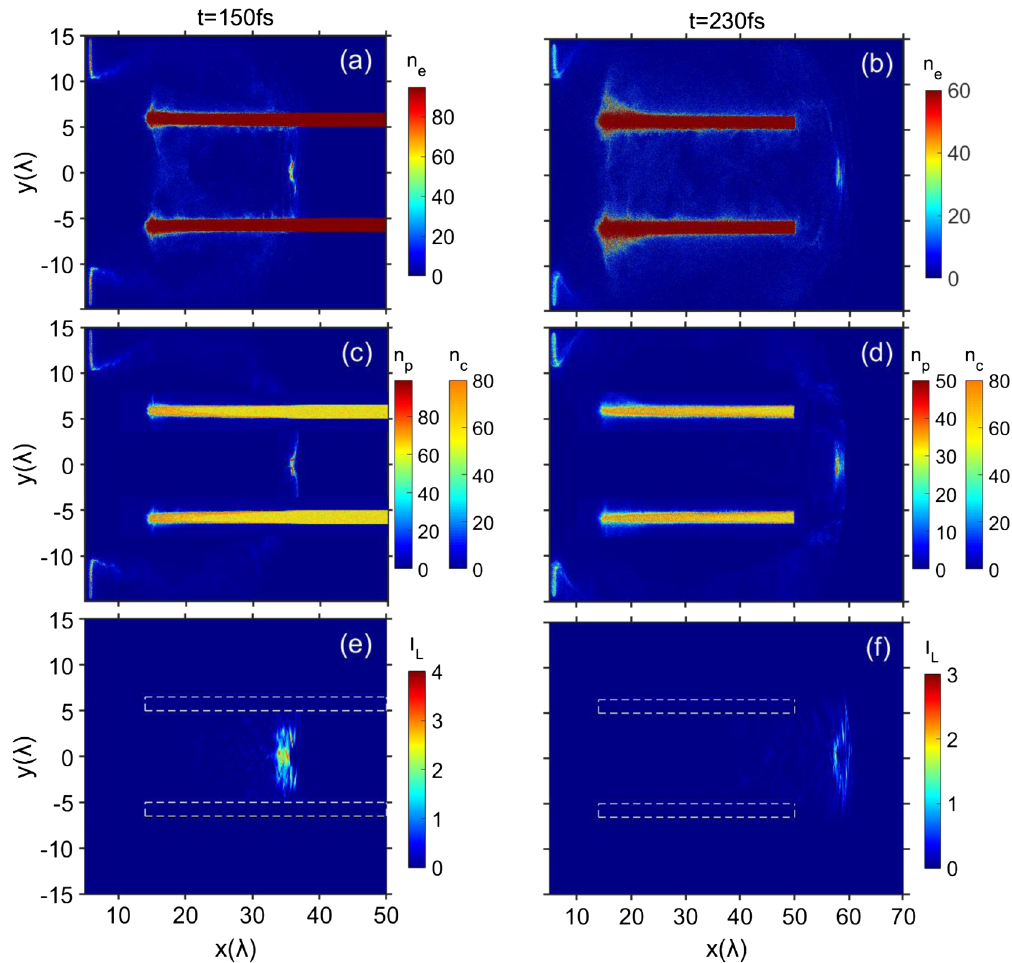
FIG. 4. Spatial distributions of electron density (a),(b), proton and carbon density (c),(d), and laser intensity (e),(f) for the case with a channel at two moments: t ¼ 150 fs and t ¼ 230 fs. The color bars represent the particle density normalized by n cr and the laser intensity normalized by E 2 0 . The dashed lines indicate the position of